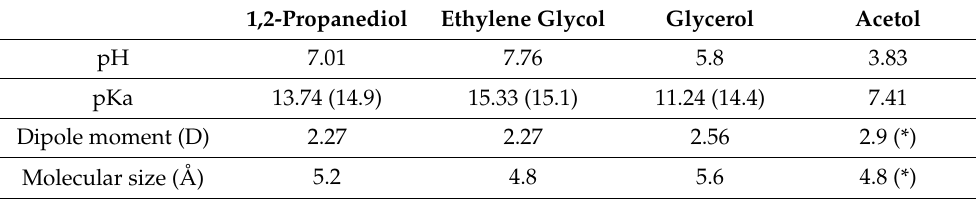
Table 4. pH, pKa, dipole moment and molecular size of the compounds.